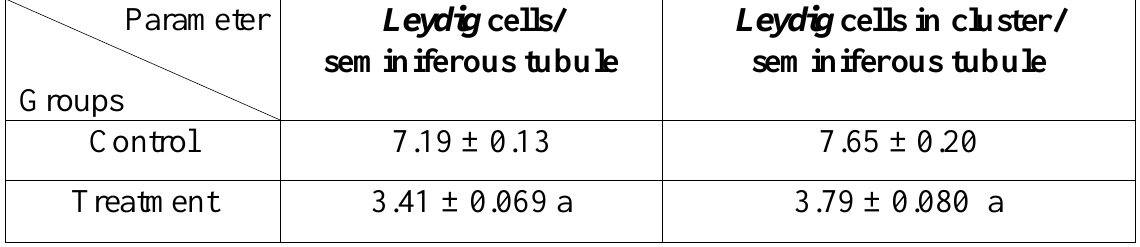
Table (3) :Total Leydig cells per seminiferous tubule and Leydig cells found in clusters per seminiferous tubule in control and gossypol treated groups (40) mg / kg BW for (42)